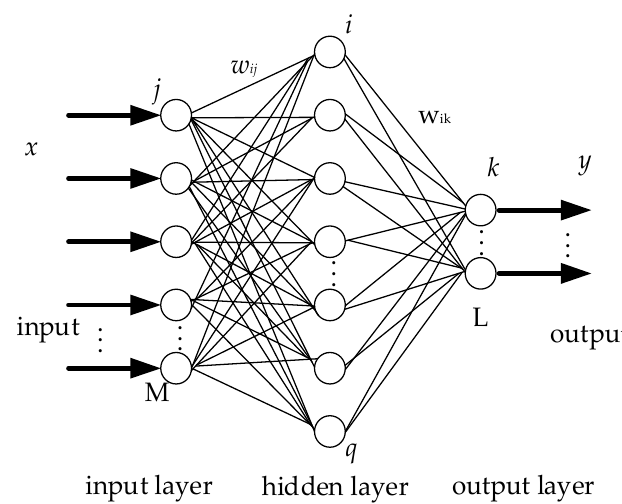
Figure 9. Schematic diagram of backpropagation (BP) neural network structure.